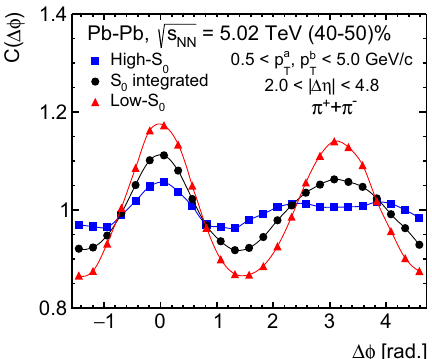
Fig. 3 One dimensional azimuthal correlation of pions for low- S 0 (red triangles), high- S 0 (blue squares) and spherocity-integrated (black cir- using AMPT model particles in | η | < 2.5 to include a wider range of particles mostly contributing to v 2 and p T > 0.5 GeV/c to be con- sistent with Refs. [10,35]. The two particle correlation func- tion, C ((cid:7)η, (cid:7)φ) can be constructed as the ratio of distri- butions for same-event pairs, S ((cid:7)η, (cid:7)φ) and mixed-event pairs, B ((cid:7)η, (cid:7)φ) , which is given by